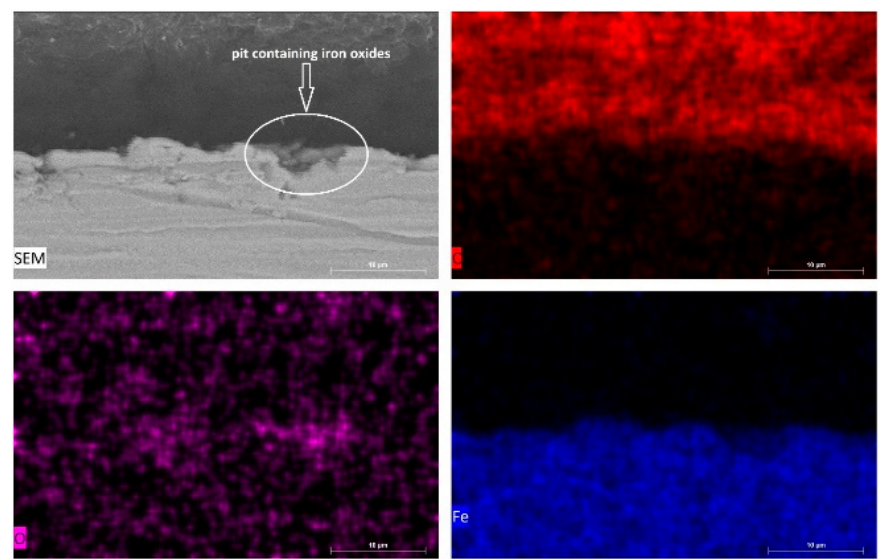
Figure 10. Cross-sectional SEM image with elemental maps for carbon steel sheet surfaces after 12 h of immersion in 10 − 3 M HCl solution (pH = 2.95).